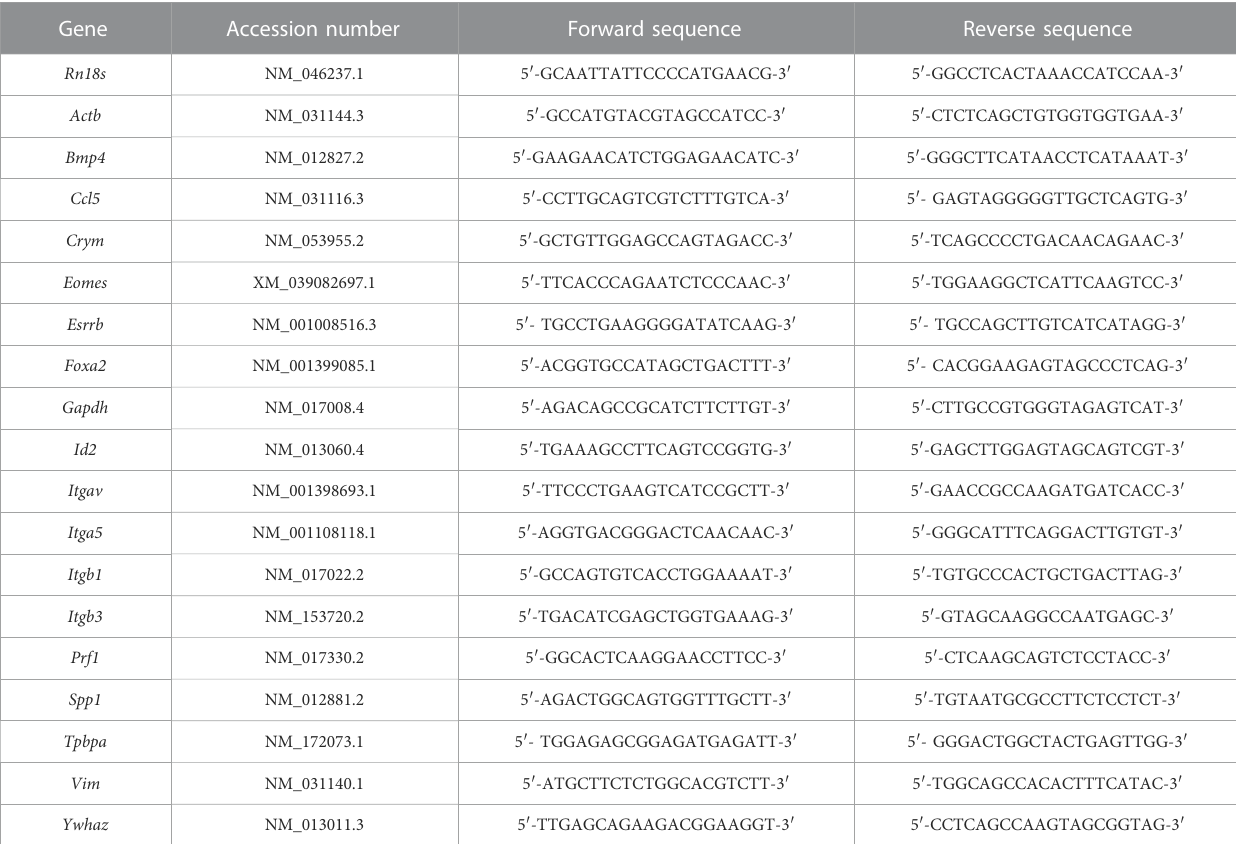
TABLE 1 Forward and reverse primers used for quantitative RT-PCR ampli fi